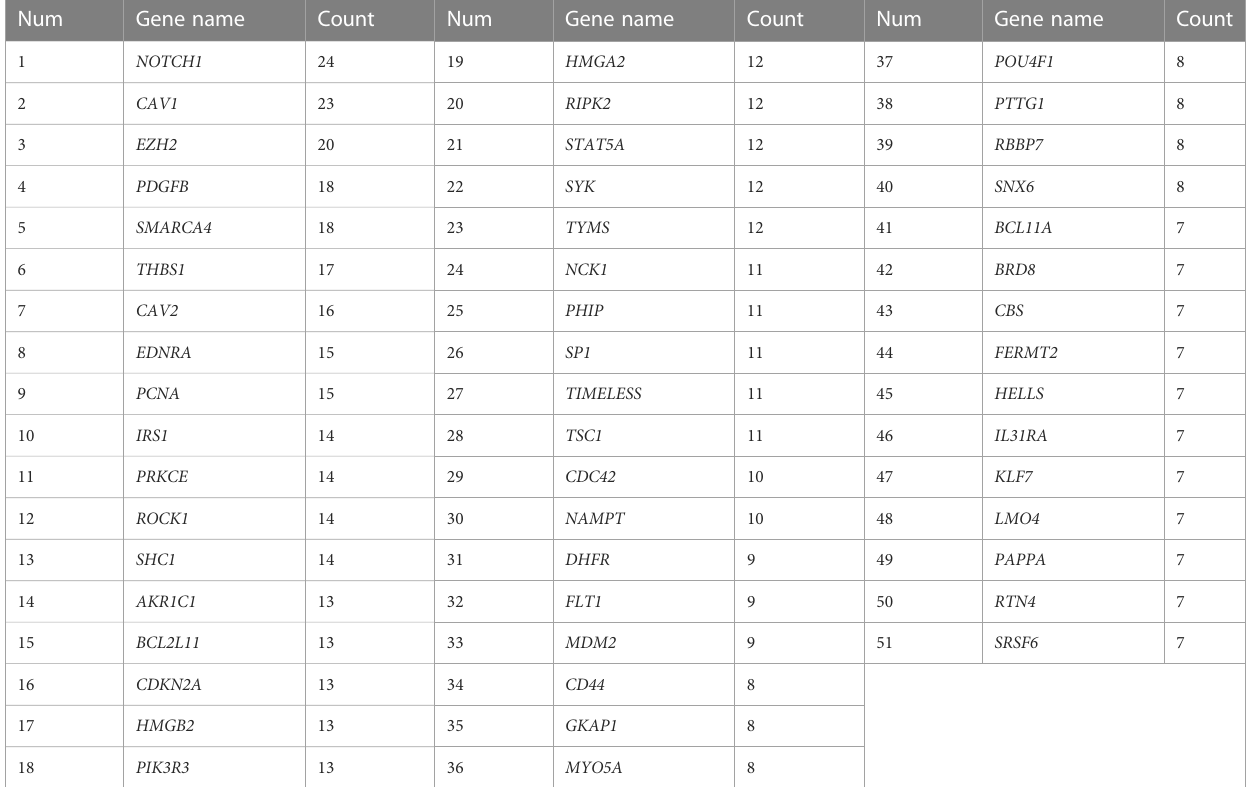
TABLE 1 The Top Frequent genes based on the count in the activated pathways using GSEA in HPV + compared to HPV - HNSCC.